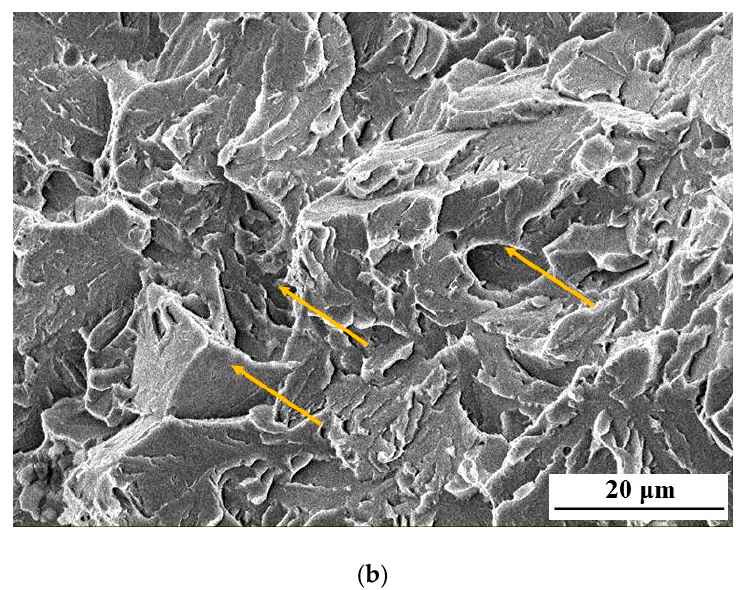
Figure 6. Fracture surfaces of samples treated 20 h at 973 K, and broken in Charpy tests at 233 K ( − 40 ◦ C), namely, in the brittle field: quenching rate from austenitic field of 3600 K/min ( a ) and 150 K/min ( b ). Arrows indicate tear ridges in ( a ), and the zones with intercrystalline fracture morphology in ( b ).